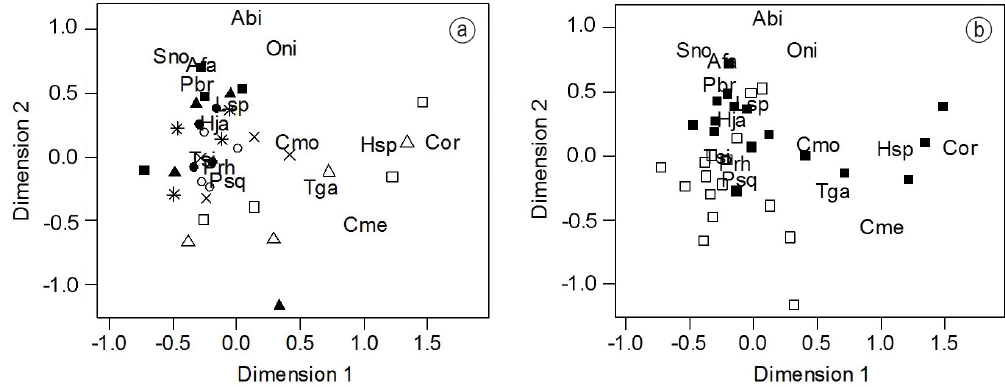
Figure 6. nMDS (stress = 0.18). (a) time at the reservoirs: PS: [∆] morning, [ □ ] afternoon, [x] evening, [ ○ ] night, EQ: [ ▲ ] morning, [ ■ ] afternoon, [*] evening, [ ● ] night; (b) season in PS and EQ: [ □ ] dry season [ ■ ] rainy season. Species: Abi: Astyanax bimaculatus , Afa: Astyanax fasciatus , Cme: Crenicichla menezesi , Cmo: Cichla monolucus , Cor: Cichlasoma orientale , Hja: Hypostomus jaguribensis , Hsp: Hoplias spp., Lsp: Leporinus spp., Oni: Oreochromis niloticus , Pbr: Prochilodus brevis , Prh: Psectrogaster rhomboides , Psq: Plagioscion squamosissimus , Sno: Steindachnerina cf. notonota